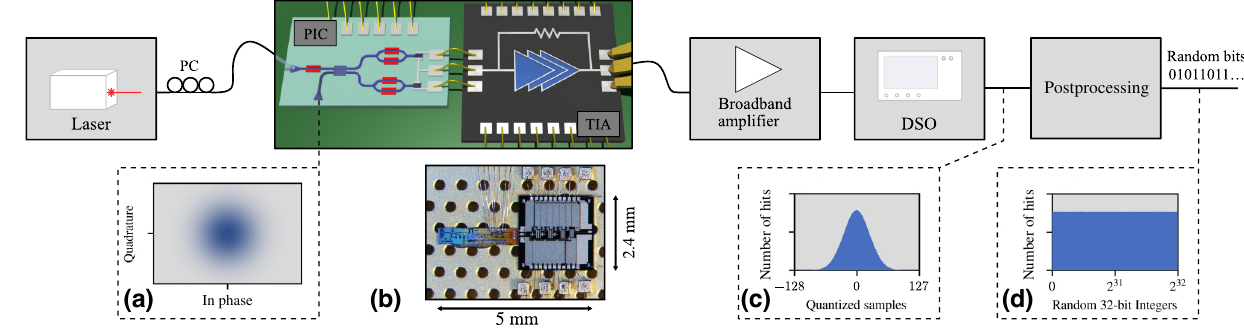
FIG. 5. An overview of the QRNG setup. (a) The vacuum noise that is used as a source to generate random numbers. (b) A micro- graph of the manufactured PIC and TIA. (c) The Gaussian distribution after digitization. (d) The distribution of the distilled random 32-bit integers, grouped into 256